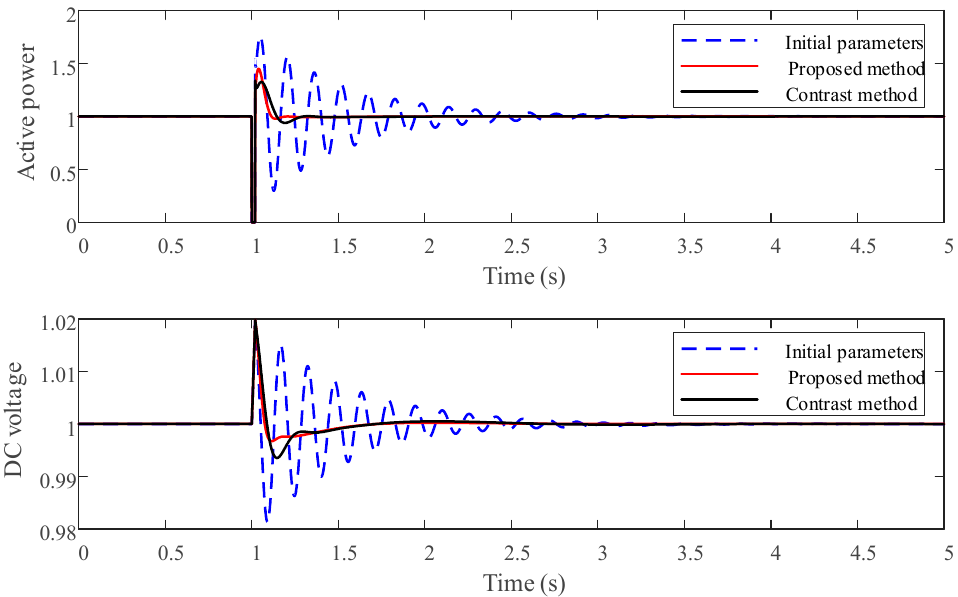
Figure 9. Active power and DC voltage of the PV-VSG with a three-phase temporary fault.